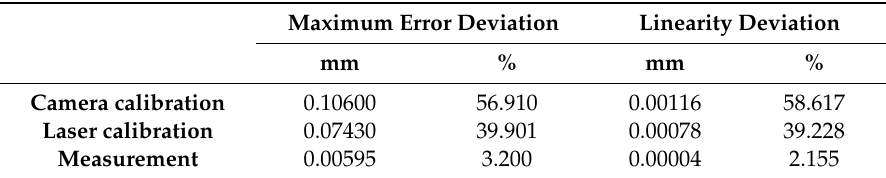
Table 4. Calibration and measurement influence on